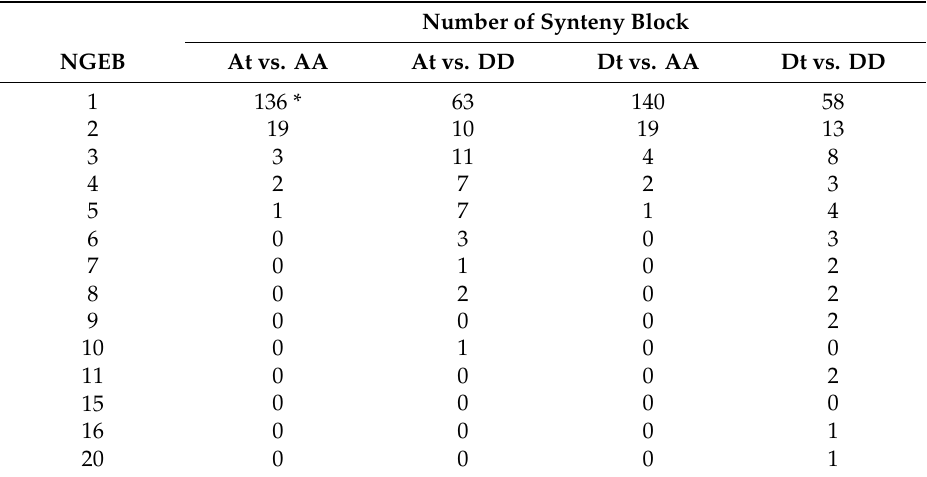
Table 1. The number of synteny blocks which including 1–20 gene number, respectively. Number of Synteny Block NGEB At vs. AA At vs. DD Dt vs. AA Dt vs.